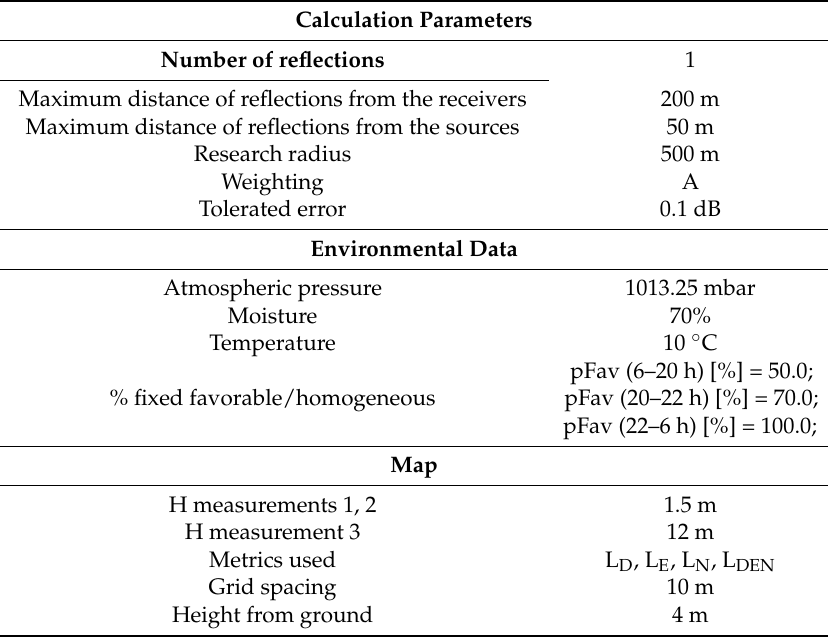
Table 1. Parameters and settings used in the noise